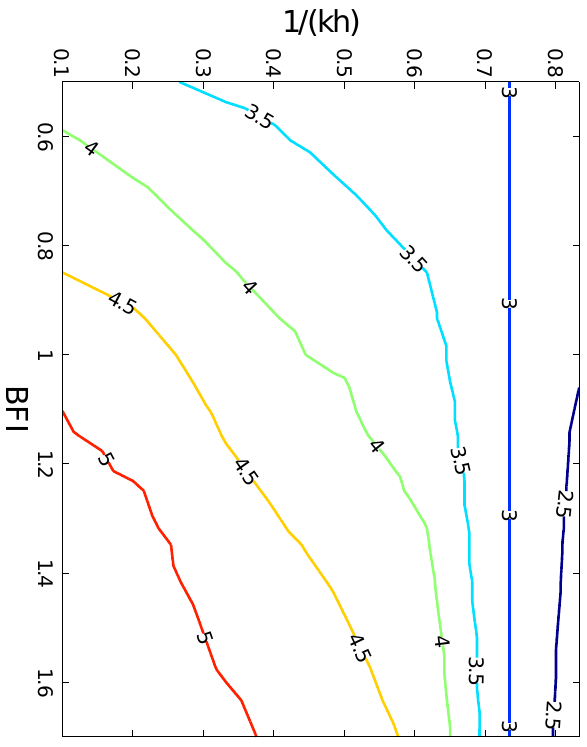
Fig. 5. Contour plot of stabilized kurtosis on flat bottom with re- spect to different initial BFI and 1/( kh ).